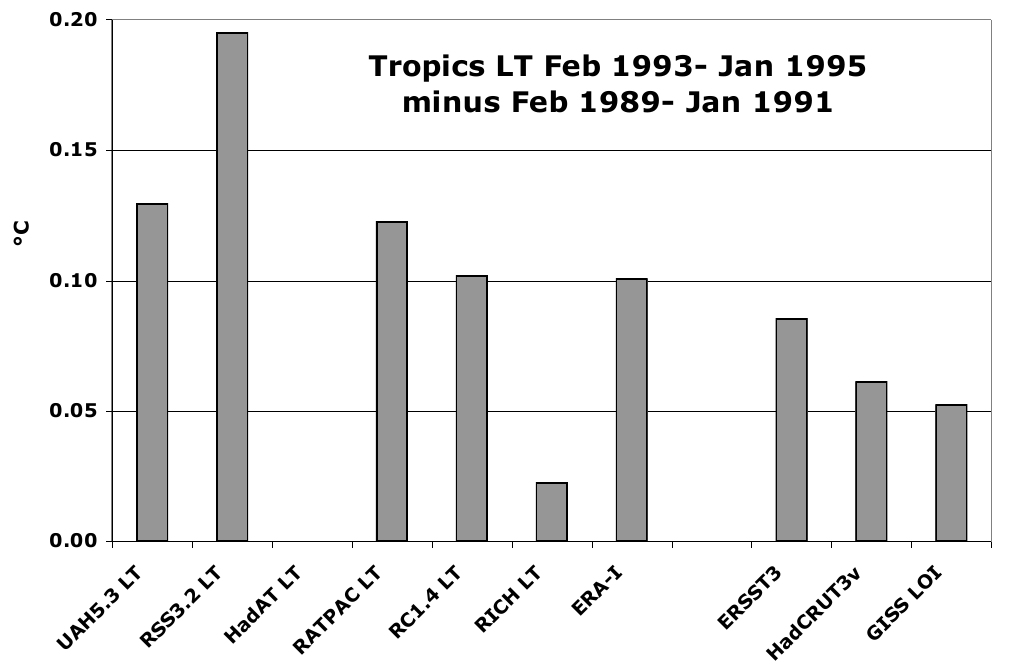
Figure 4. Difference of averages of two two-year periods, 1993–1995 minus 1989–1991 for T datasets (7 left bars) and T (right 3 bars.) Note that HadAT indicates a difference LT sfc of 0.00